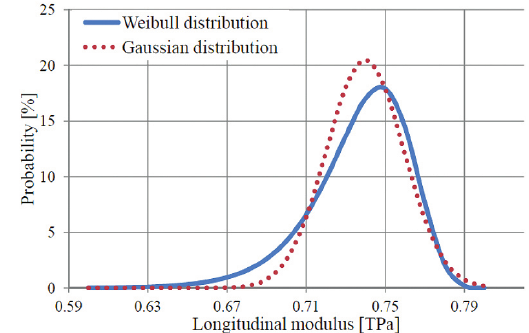
Figure 16. The Weibull and Gaussian plot of defected CNT (12,0) with 5% of the defect